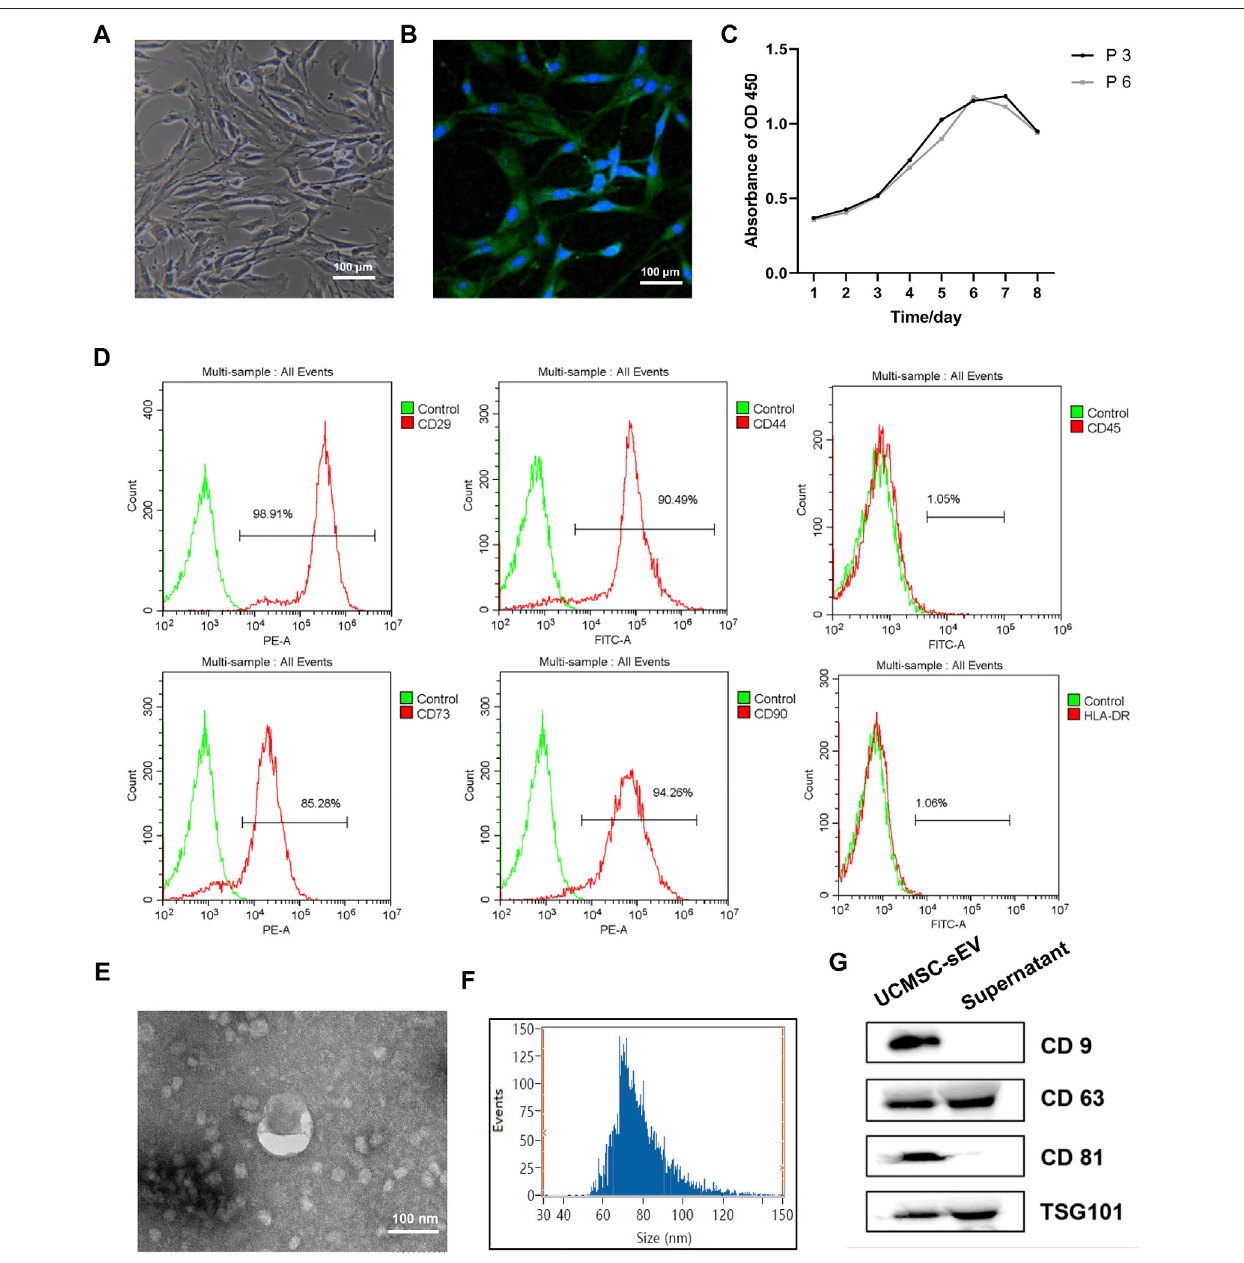
FIGURE 1 | Identi fi cation of PUMSCs, UCMSCs and UCMSC-sEV. (A) Morphology of PUMSCs. (B) Immuno fl uorescence staining results show that the isolated PUMSCs express α -SMA, a smooth muscle cell surface marker. (C) Growth curve of PUMSCs. (D) Flow cytometric analysis of MSC surface markers shows that UCMSCs express high levels = of CD29, CD44, CD73, and CD90 but do not express CD45 and HLA-DR. (E) Transmission electron microscopy shows that the UCMSC-sEVarecup-shapedvesicles.Scalebar=100 nm. (F) NanoFCManalysisoftheparticlesizeofUCMSC-sEV. (G) Westernblottingwasusedtodetectthe expression of the sEV marker proteins CD9, CD63, CD81, and TSG101.